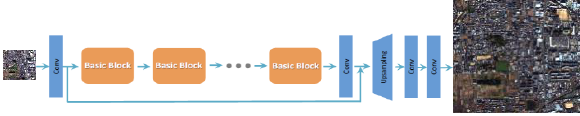
Figure 4 . Basic network architecture of SRResNet model.